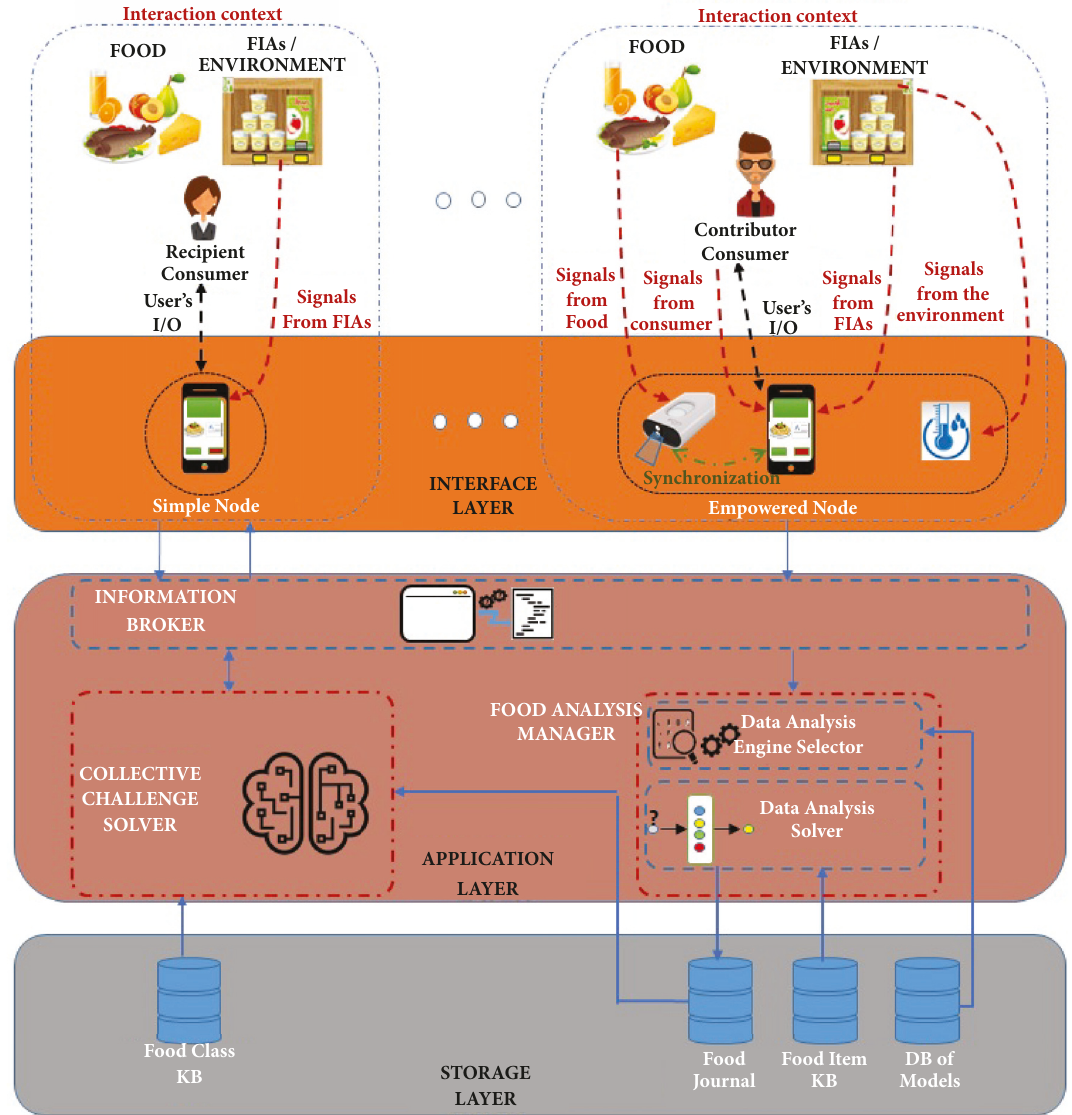
Figure 2: A three-tier architecture for the CFA